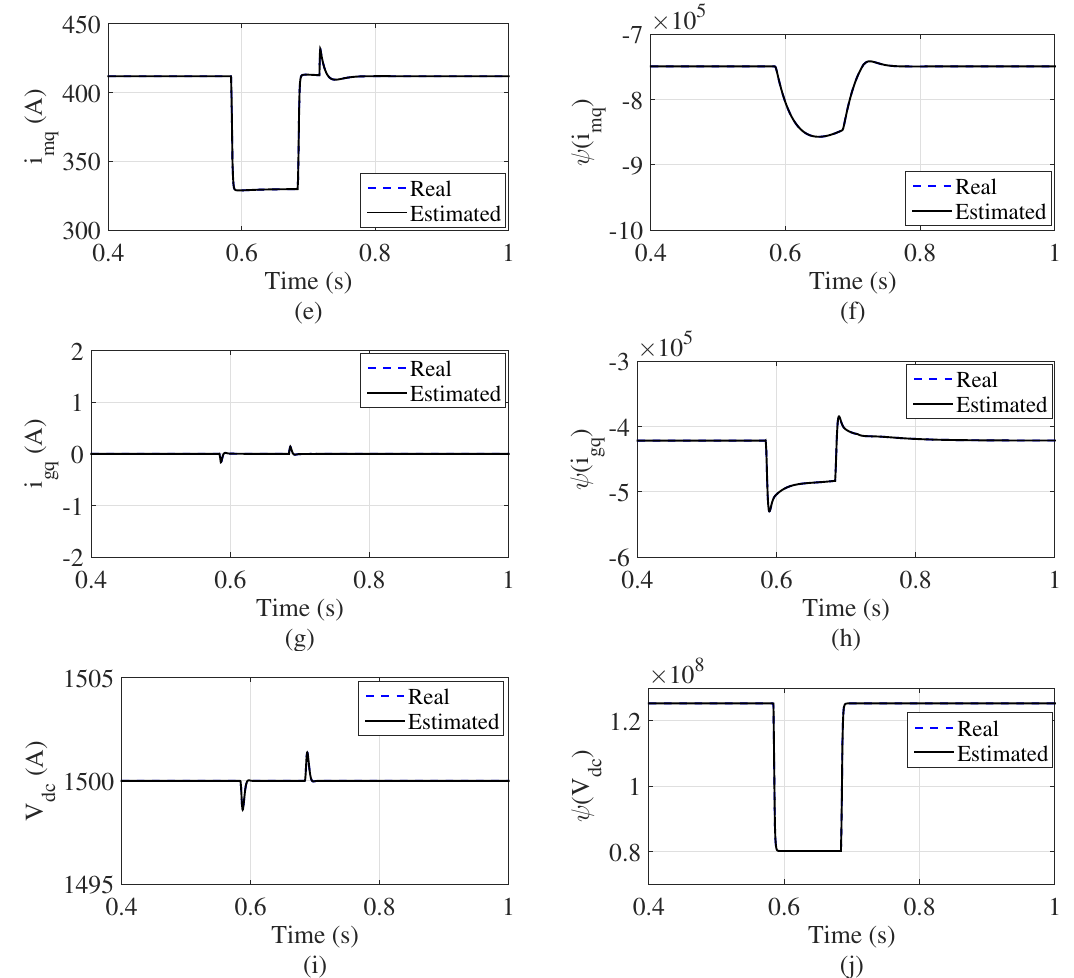
Figure 15. Estimates of states and perturbations to constant wind speed with protection under grid voltage dips. ( a ) Estimation of mechanical rotation speed ω m . ( b ) Estimation of perturbation term Ψ ( ω m ) . ( c ) Estimation of i md . ( d ) Estimation of perturbation term Ψ ( i md ) . ( e ) Estimation